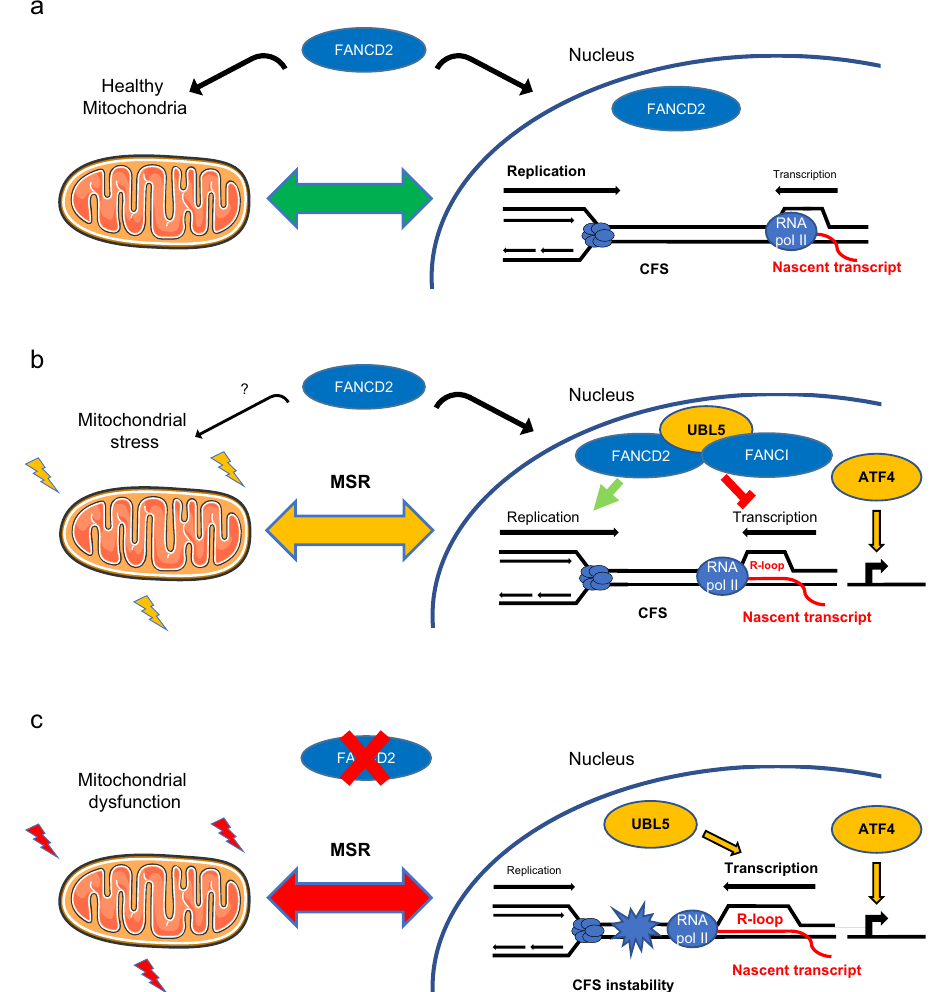
Fig. 7 FANCD2 maintains mitochondrial homeostasis and genome stability by tuning the mitochondrial stress response. a FANCD2 coordinates nuclear and mitochondrial activities to prevent mitochondrial dysfunction and maintain the mitochondrial stress response (MSR) in check. b Upon mitochondrial stress, FANCD2 relocalizes to CFS and dampens the UBL5-dependent mtUPR, limiting transcription – replication con fl icts. c In the absence of FANCD2, mitochondrial dysfunction activates a mitochondrial stress response involving the ATF4 pathway and unrestrained UBL5-dependent CFS gene transcription, leading to transcription-replication collisions and CFS